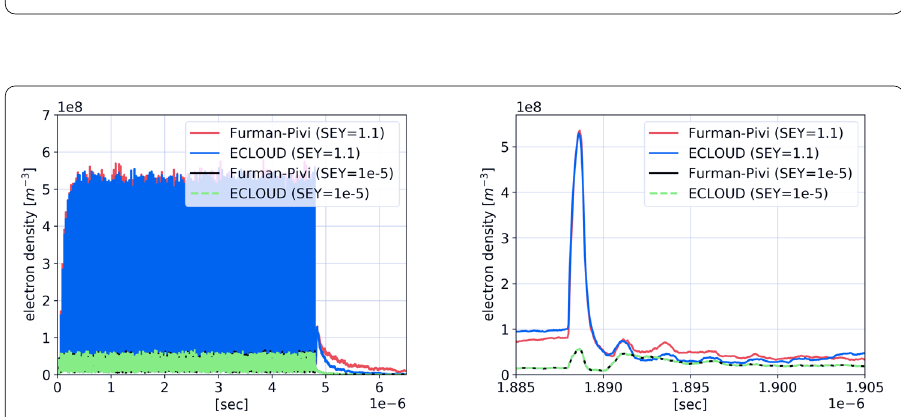
Figure 6 Minimum central electron cloud density versus time, comparing SEY models and defining the reference electron formation level for SEY ≈ 0. Leftfigure : n (cid:4) γ = 10 –6 , BS = 32 ns, N b = 2.8 × 10 11 , rightfigure : Zoomed view of the left picture at the moment of a bunch